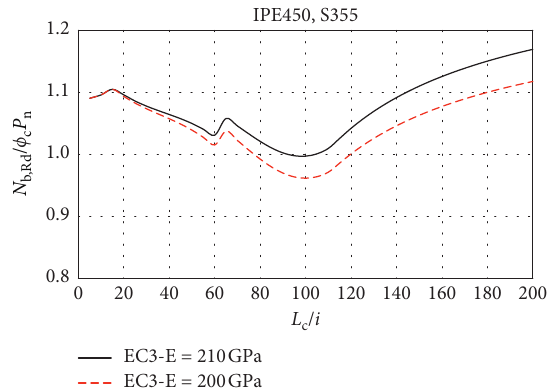
Figure 7: The effect of different values of elasticity modulus on the capacity ratio curve plotted for a member with IPE450 section and S355 steel grade. The black and solid curve presents the capacity curve with design resistances calculated using E c � 210GPa whereas the red and dashed curve presents that calculated using E c �